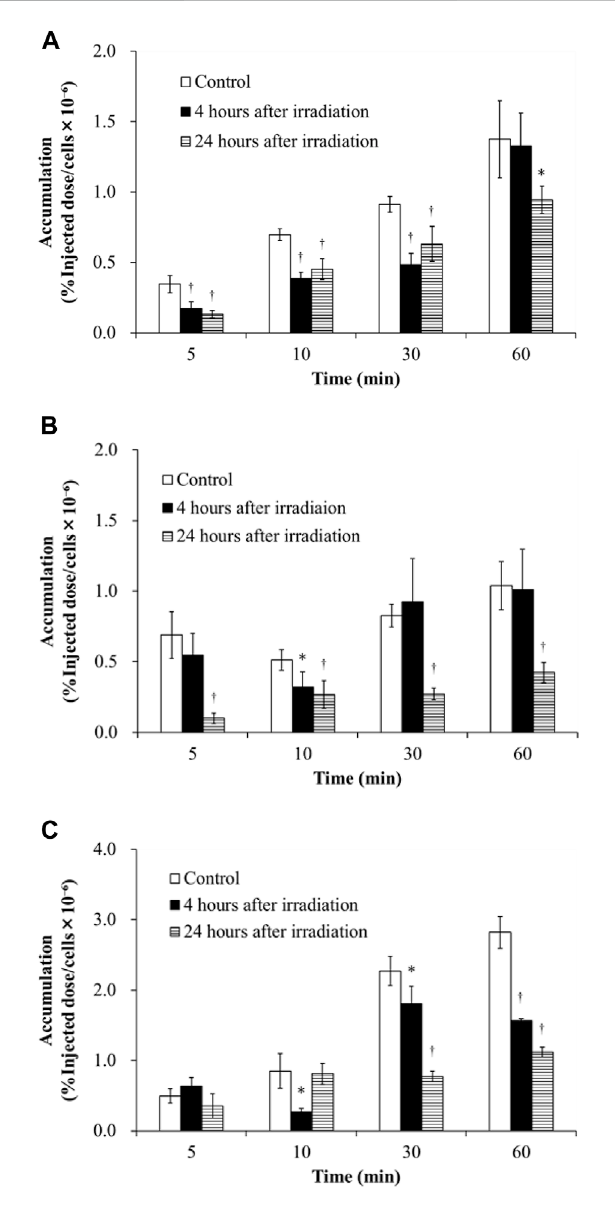
Accumulation of 3 H-MTX in H441 (A) , PC-14 (B) and HeLa (C) cells in the three groups including control, 4 h after irradiation and 24 h after irradiationat5,10,30,and60 minafteradding 3 H-MTX.Accumulationof 3 H-MTXtendedtodecreaseafterirradiationinallthreecancercells. † p < .01 and * p < .05 vs.